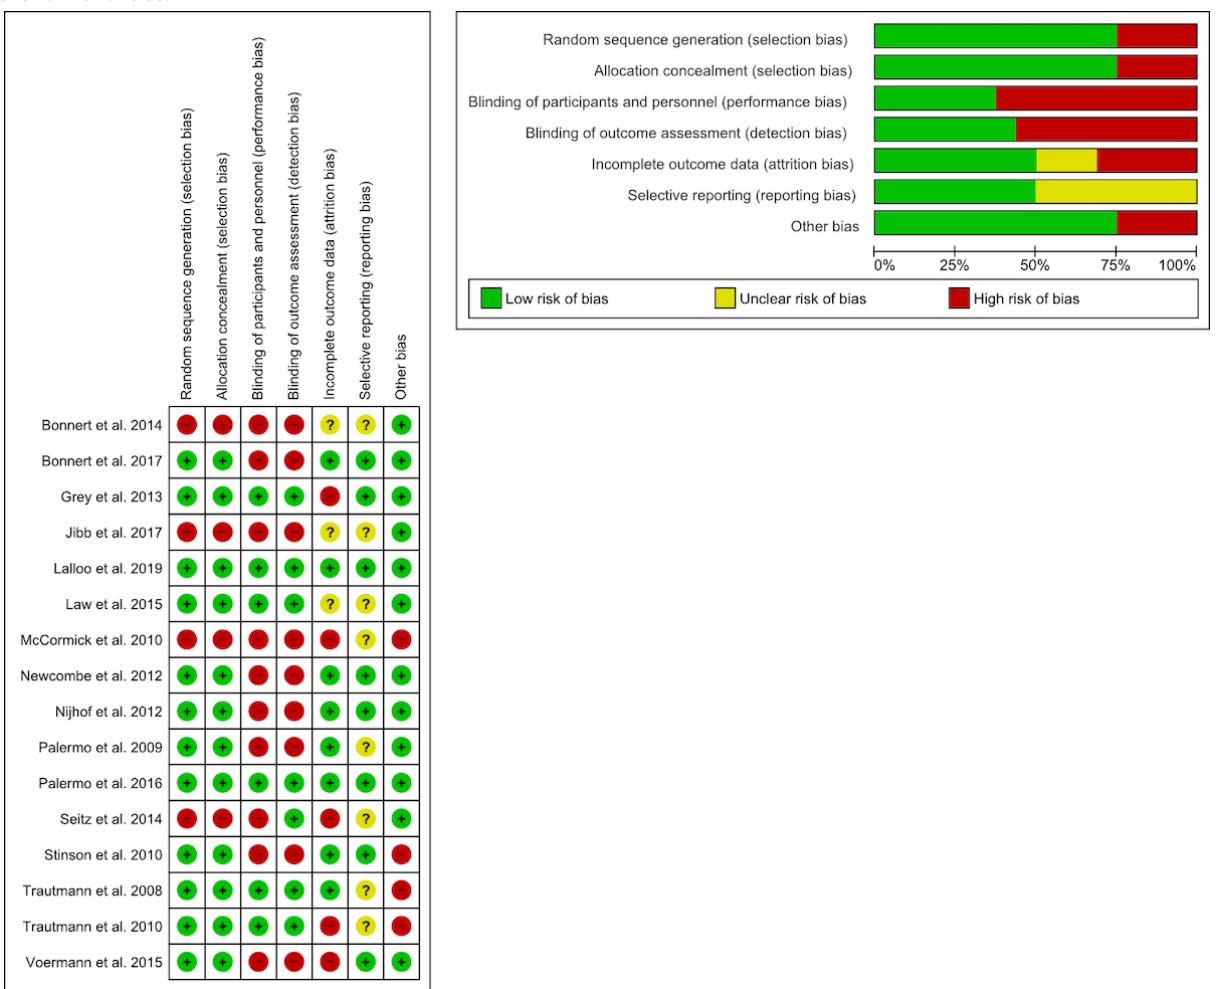
Figure 2. Risk of